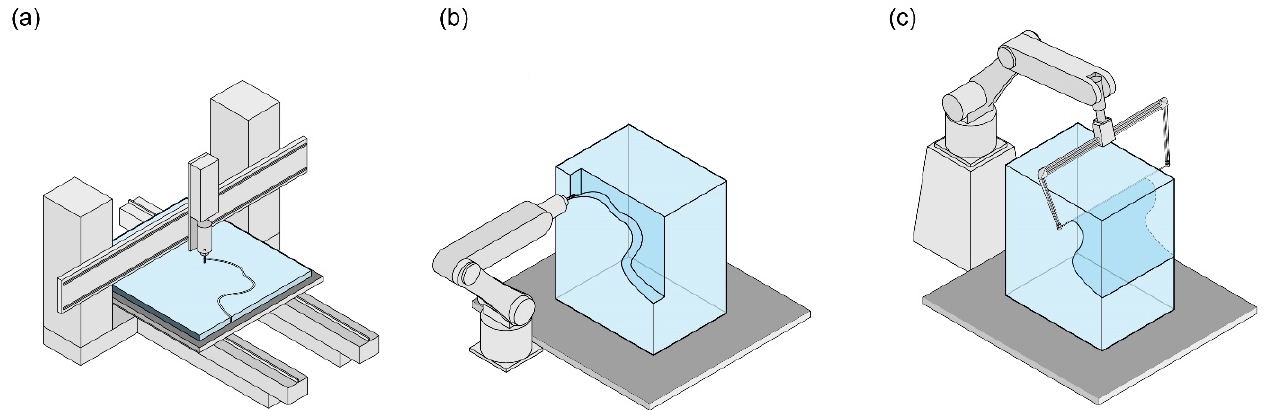
Figure 3. Typical subtractive manufacturing techniques: ( a ) milling (cutting) flat, panel-like specimen; ( b ) milling (carving) volumetric specimen; and ( c ) wire-cutting volumetric specimen. Milling